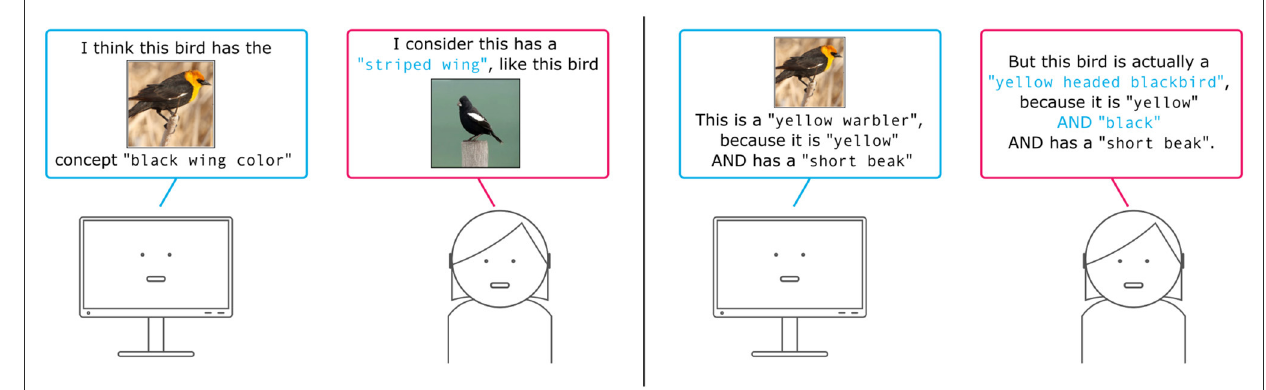
FIGURE4 Illustration of providing feedback on concept learning and concept aggregation strategies. (Left) In concept learning a model learns a set of basic concepts that are present in the dataset. Hereby it learns to grounding specific features of the dataset on symbolic concept labels. (Right) Given a set of known basic concepts a model could falsely aggregate the concept activations leading to a false final prediction. Users can provide feedback on the concept